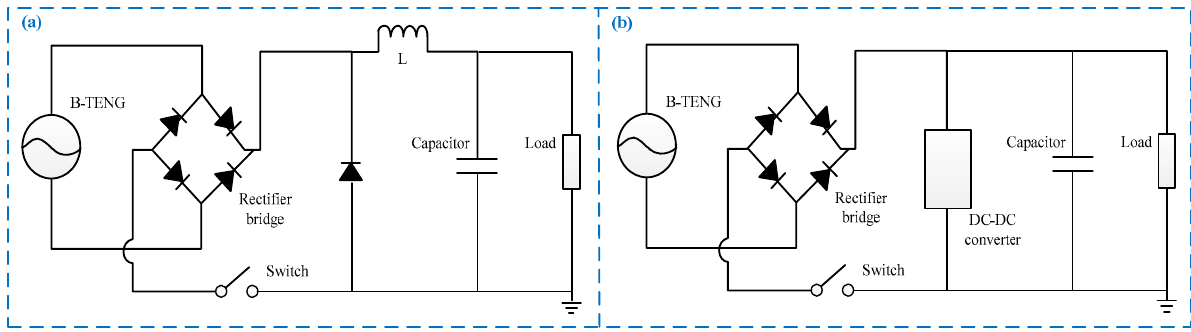
Figure 6. The output circuit of the sensor. ( a ) Energy processing circuit; ( b ) low-voltage output energy processing